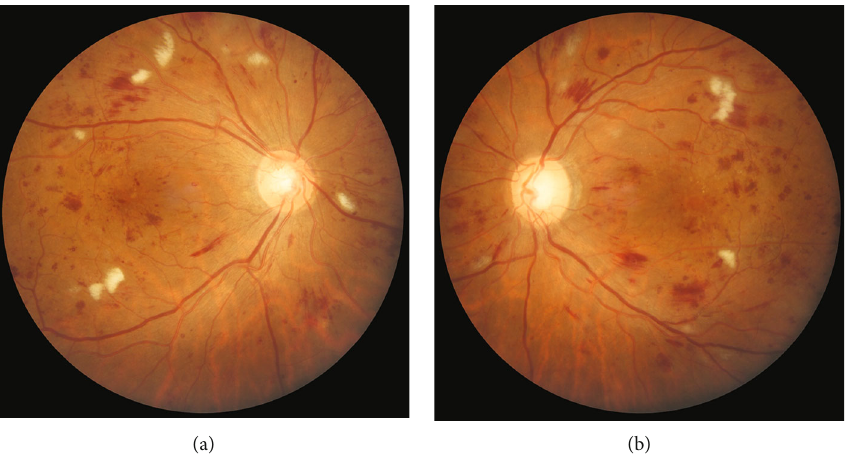
Figure 1: Fundus photographs of both the eyes demonstrating severe nonproliferative diabetic retinopathy (NPDR) with clinically signi fi cant macular edema (CSME) (a,